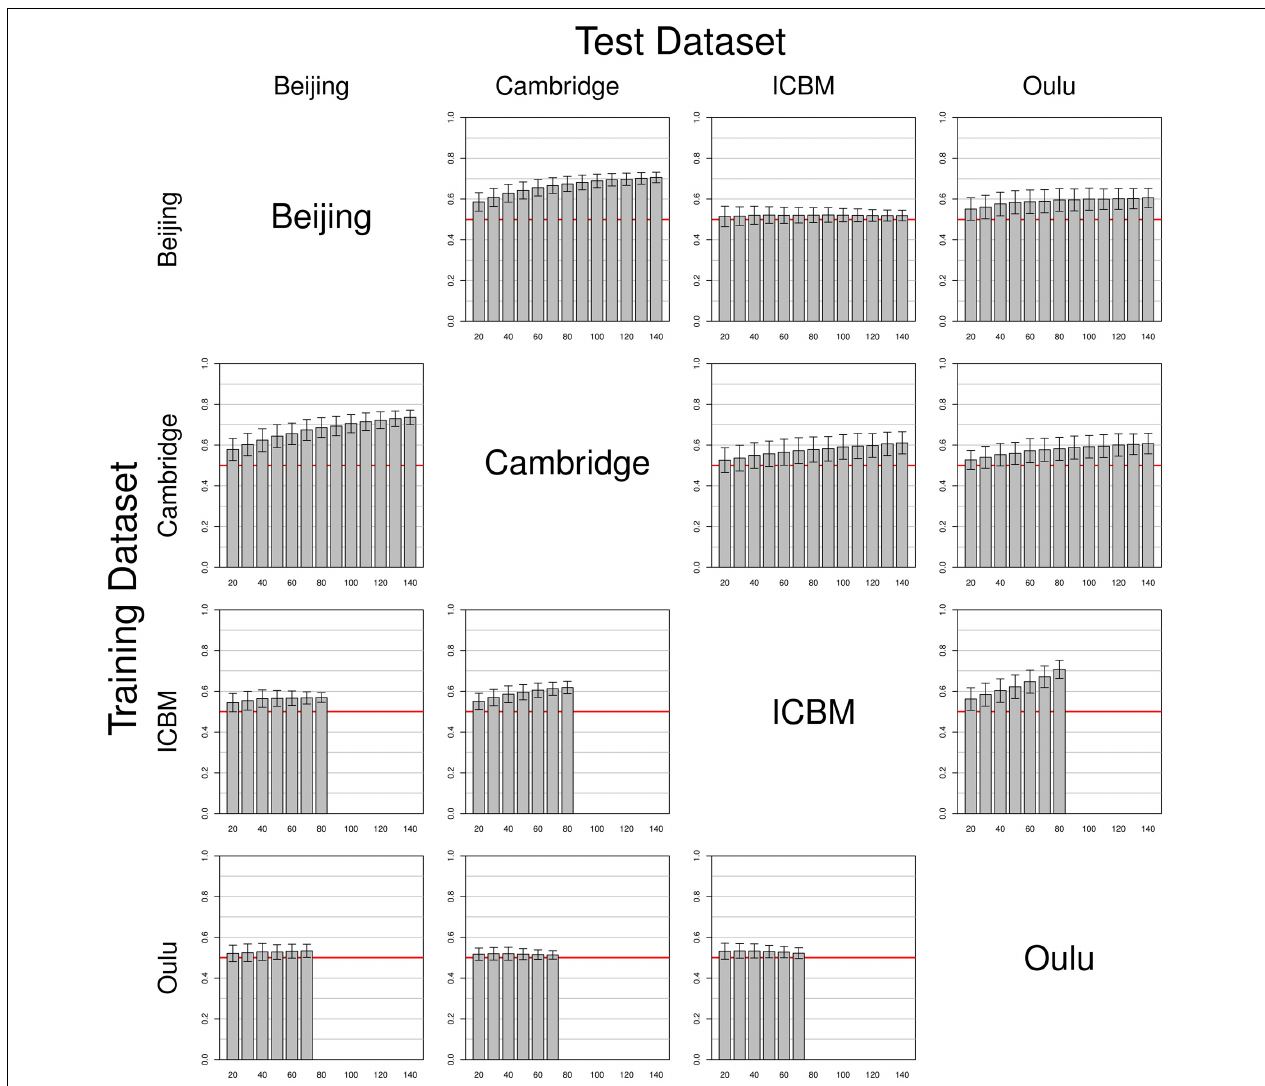
FIGURE 4 | Simulations using test and training datasets from two different studies among the four largest FCon datasets, with each row having the same study as a source for training datasets (varying training dataset size) and each column having the same study as a source for the test datasets (fixed test sample size, see